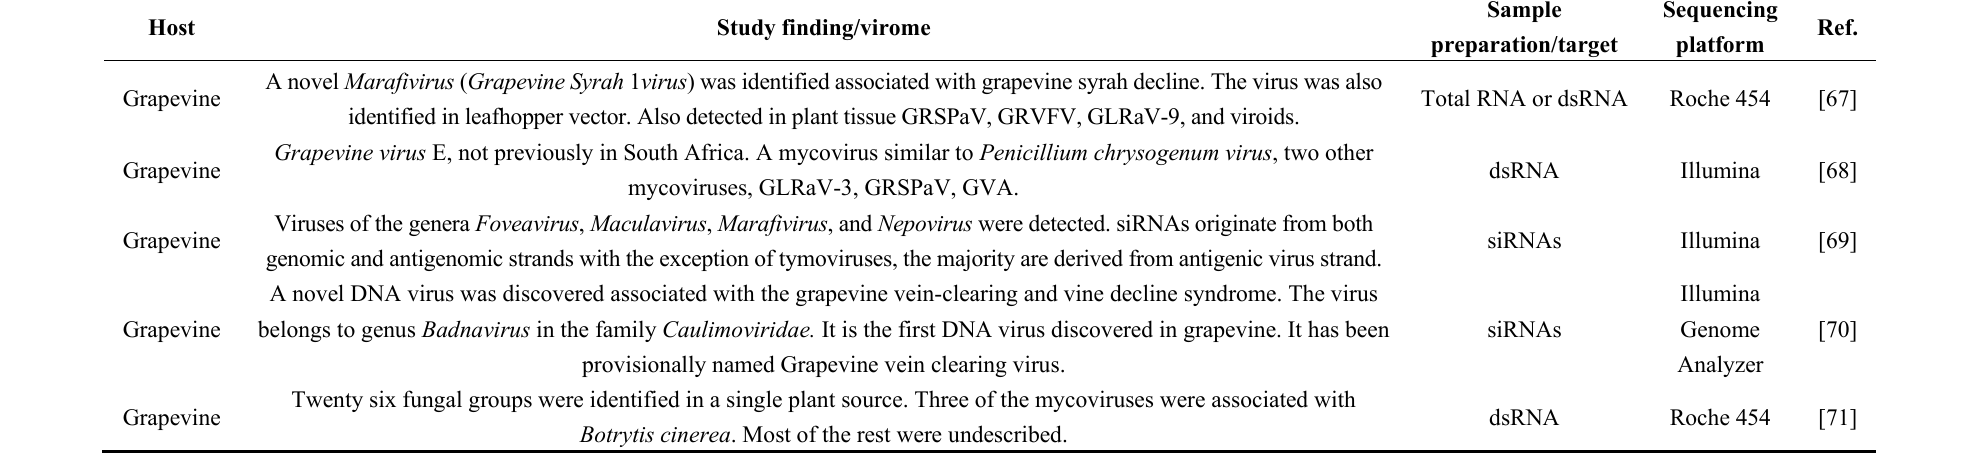
Table 5. Next-generation sequencing of plant viral siRNA, total RNA or dsRNA from virus-infected